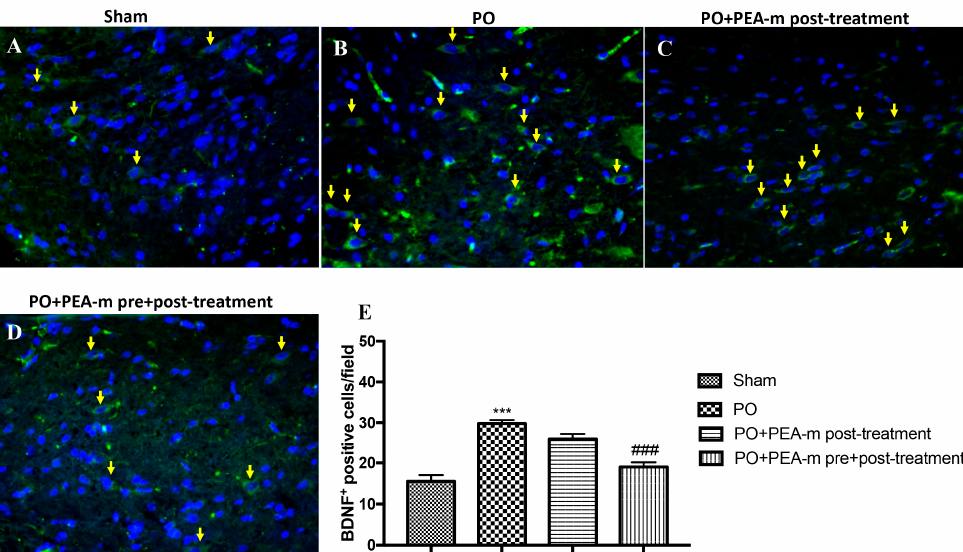
Figure 5. Effects of PEA-m on brain-derived neurotrophic factor (BDNF) expression in lumbar spinal cord after PO. Immunofluorescence for BDNF expression (green) in sham rats ( A ), the PO group ( B ), the PO + PEA-m post-treatment group (C), and the PO + PEA-m pre + post-treatment group ( D ). Yellow arrows show BDNF expression. Data are demonstrative of at least three separate experiments. Images are representative of all animals in each group. The graphs next to the panel represent the positive BDNF cells. All images were digitalized at a resolution of 8 bits into an array of 2048 × 2048 pixels. Pictures were captured at 40 × magnification. ( E ) *** p < 0.001 vs. sham; ### p < 0.001 vs. PO.